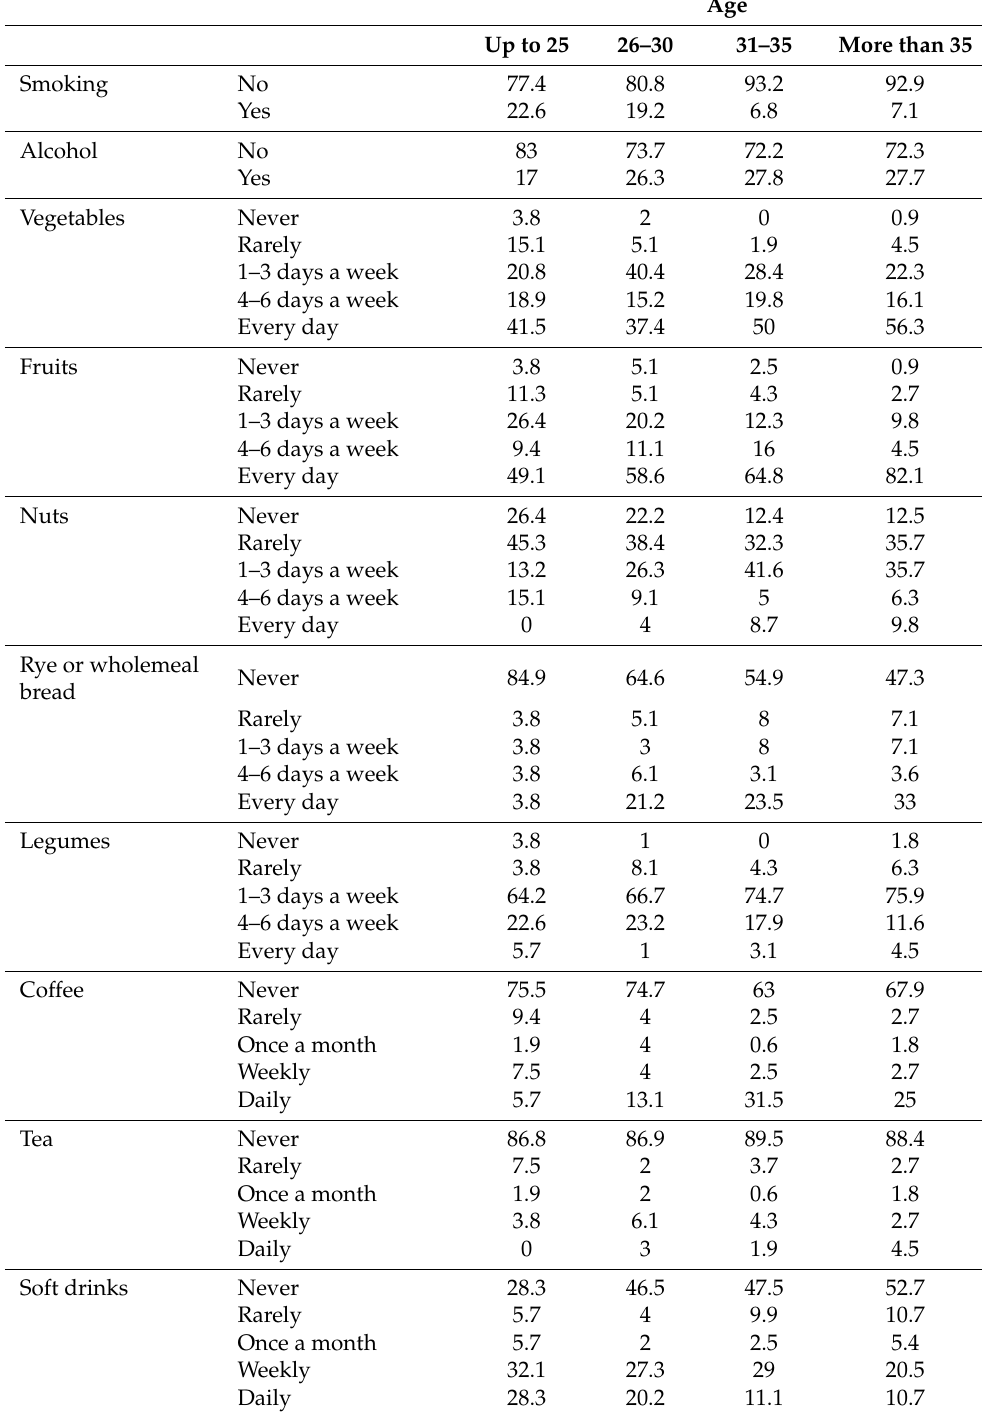
Table 3. Percentage distribution of study variables by